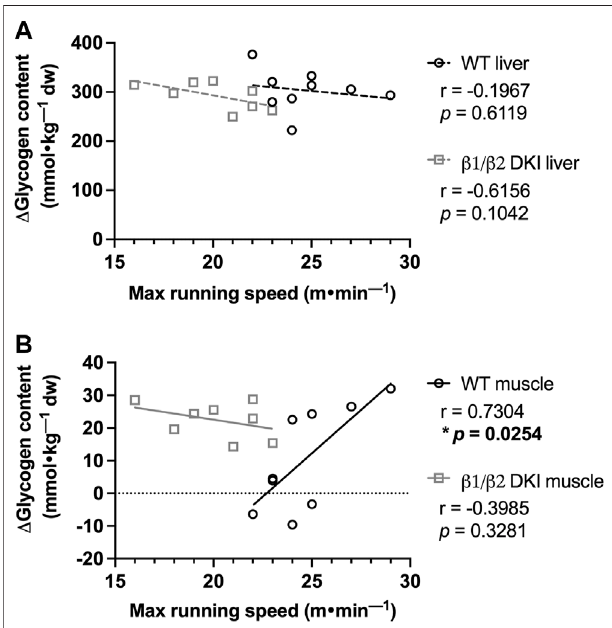
FIGURE 5 | Maximal running speed at a 5 ° incline is positively correlated with skeletal muscle glycogen utilization following maximal running in WT but not DKI mice. (A) Correlation between maximal running speed and change in liver glycogen was not signi fi cant in either WT or DKI mice. (B) WT mice display a signi fi cant positive correlation between maximal running speed and change in skeletal muscle glycogen between the rested state and following maximal treadmill running, which was not observed in DKI mice. Male mice, 17 – 20 weeks, n = 8 – 9. * p < 0.05.